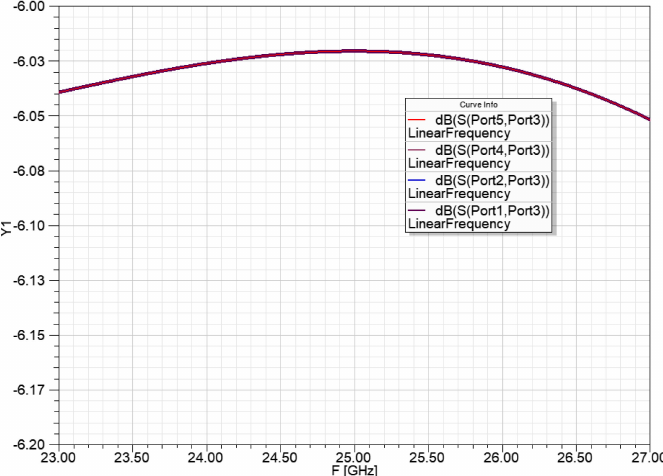
Figure 12. Power ratio for the four radiators of the power division network for 1 to 4 power ratio, with ideal transmission